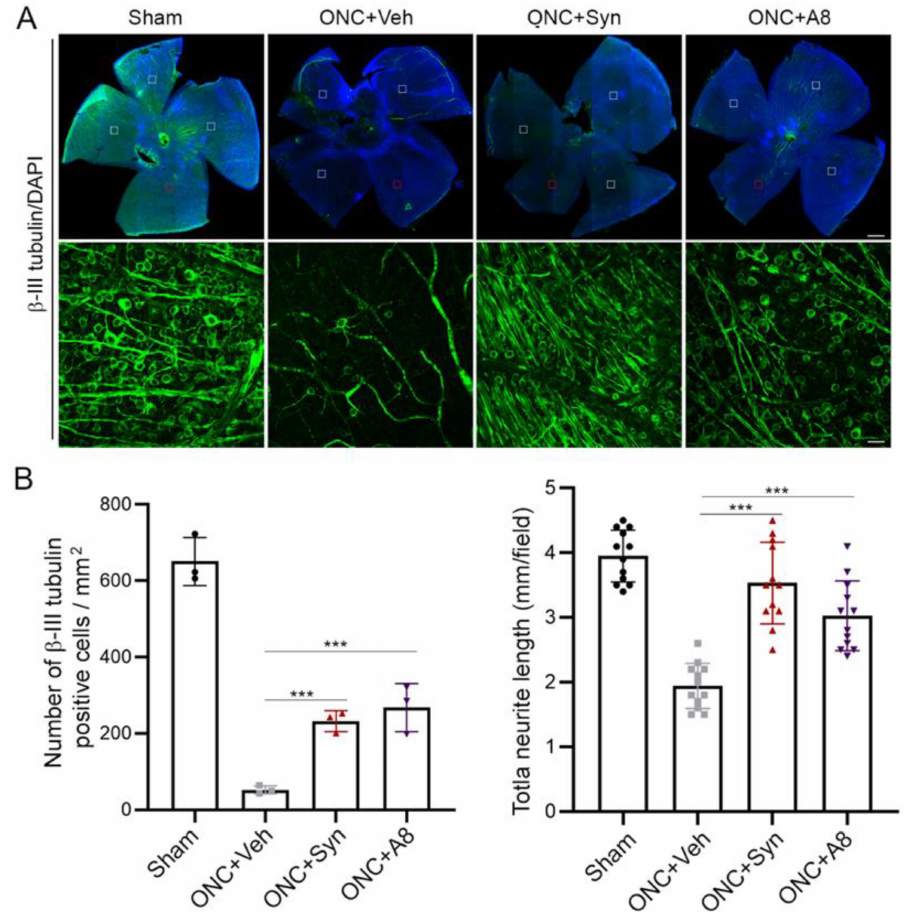
Figure 6. ONC-induced RGC loss was alleviated by synaptamide or A8 treatment. ( A , B ) Confocal images of whole mount retina where RGCs were visualized by b-III tubulin (green) and DAPI (blue) at 12 weeks post-ONC ( A ), indicating significantly greater numbers of neurons and neurites after synaptamide or A8 treatment compared to the vehicle-treated ONC control ( B ). A representative image from the red-outlined boxed region is also shown with higher magnification (( A ), bottom). The number of b-III tubulin-positive RGC neurons and total neurite length were quantified for 4 fields (boxed regions) per retina from three animals ( B ). Scale bars in ( A ), 400 µ m (top), 20 µ m (bottom). *** p <